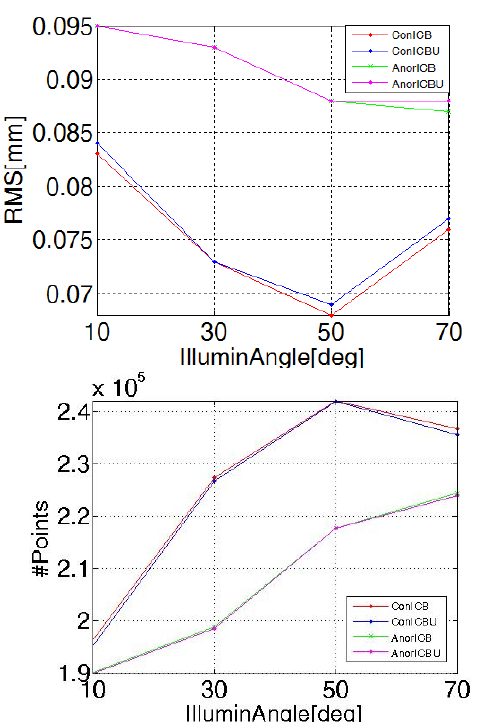
Figure 8: Top: graph of RMSE for both the concrete and the anorthosite samples with and without compressed background, at various illumination angles. Bottom: graph of the number of “good points” in the same cases as